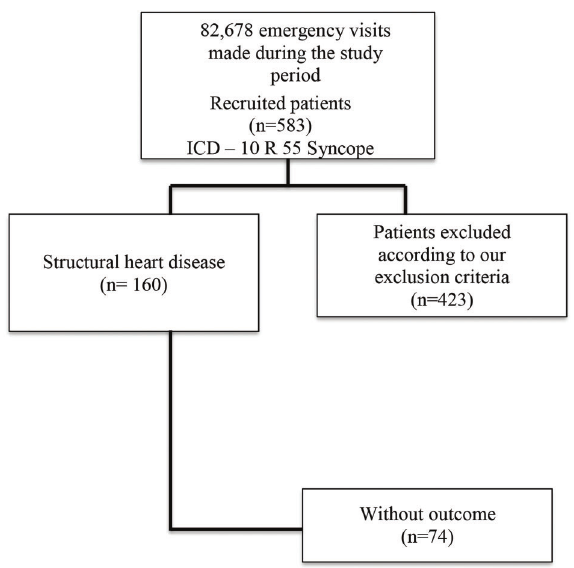
Figure 1. Study fl ow chart. ICD: International Classi fi cation of